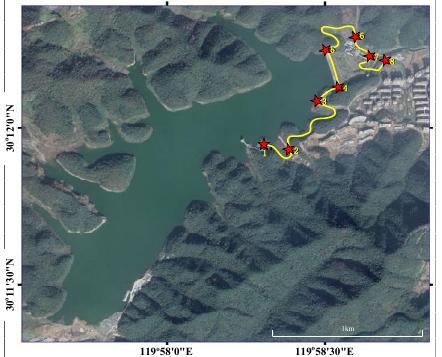
Figure 4. The route and 8 points of gravity measurement around Xianlin